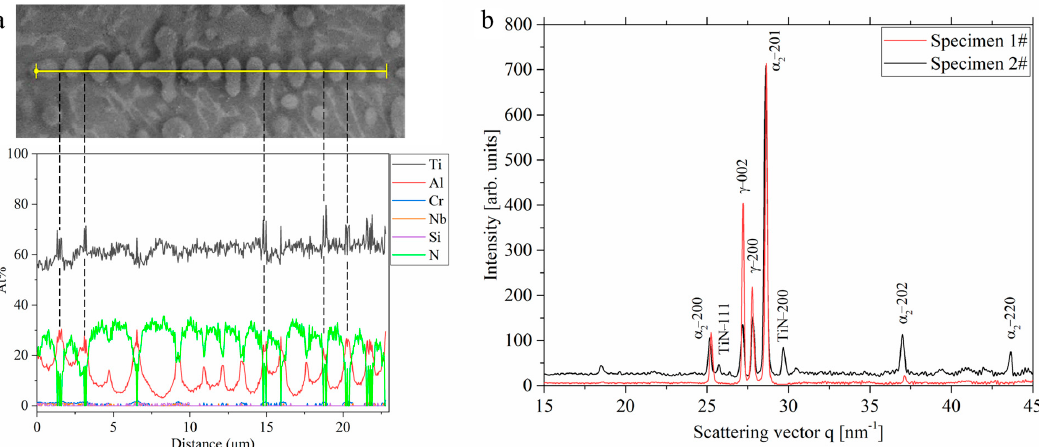
Figure 3. ( a ) Chemical composition analysis of dendrite by EDS and ( b ) micro-area XRD of welding zone in samples 1# and 2#.